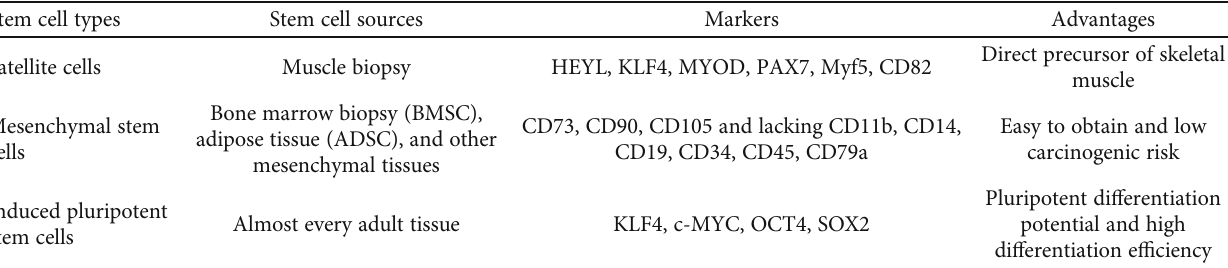
Table 2: Stem cells in myogenic di ff